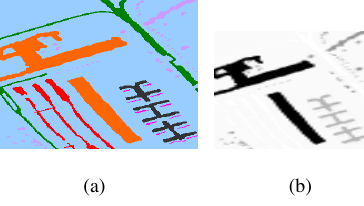
Figure 3. Simulated hyperspectral imagery :(a) True distribution, (b) 30 th band grey